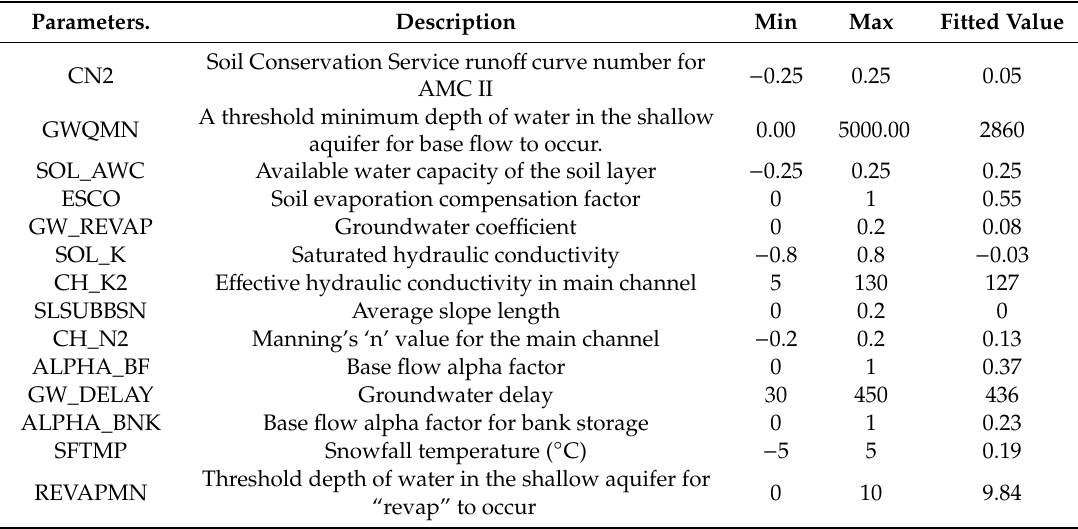
Figure 5. Watershed contributing runoff to 2FC05. Table 4. Final fitted parameters.